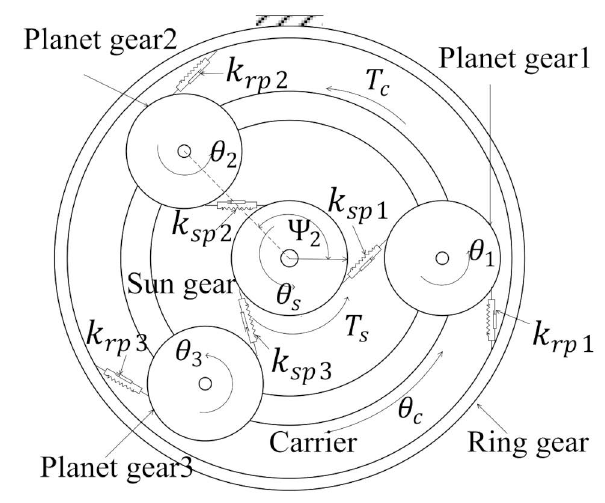
Figure 3. Planetary gearbox torsional